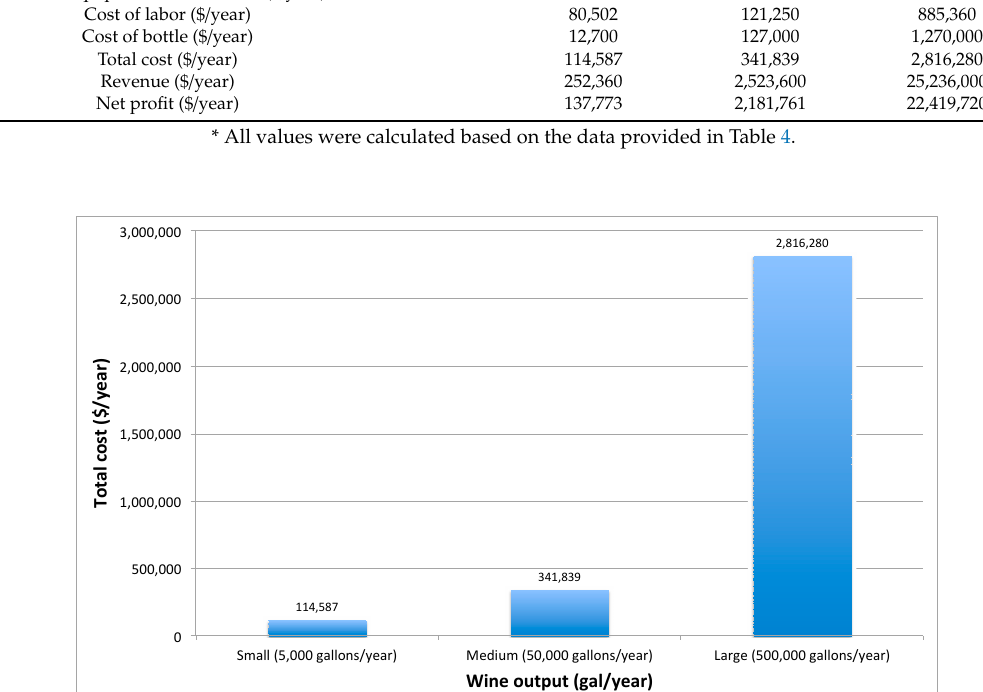
Figure 3. Total annual production costs according to scale of operation.